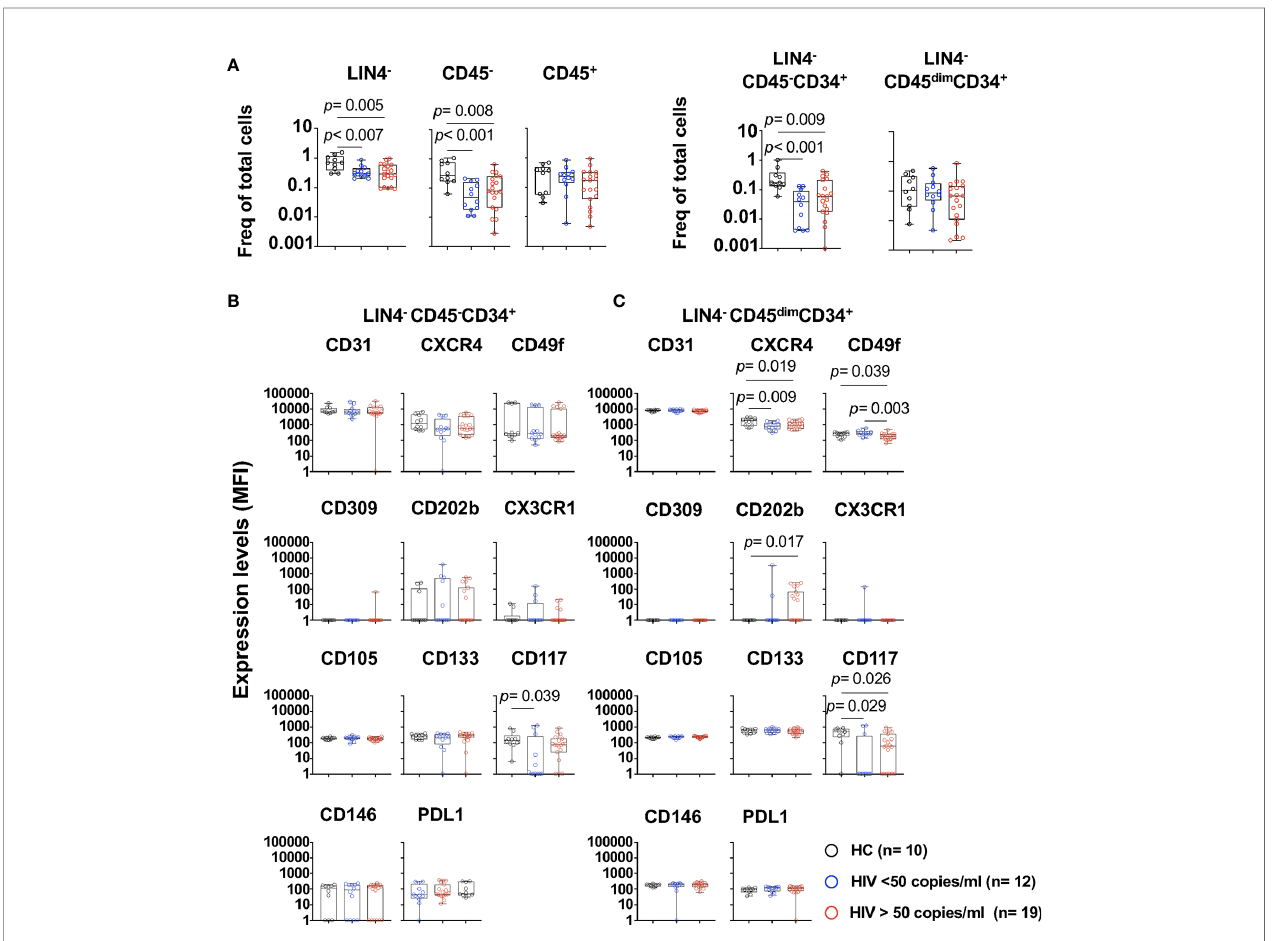
FIGURE 2 | Phenotype of circulating cell progenitors LIN4 - CD45 - CD34 + and LIN4 - CD45 dim CD34 + in PWH. PBMCs from healthy control (HC, n=10), PWH with viral loads < 50 copies/ml (n= 12), and > 50 copies/ml (n= 19) were thawed and rested overnight. PBMCs were stained with LIVE/DEAD followed by a cocktail of mAbs: LIN4, CD45, CD34, CD31, CXCR4, CD105, CD49f, CD133, CD146, PDL-1, CD309, CD117 and CD202b ( Supplementary Table S2 ). (A) Percentage of LIN4 - , LIN4 - CD45 - and LIN4 - CD45 + (Left panel), and percentage of LIN4 - CD45 - CD34 + and LIN4 - CD45 dim CD34 + (Right panel). Percentages are represented as frequency of total live cells. Expression of the markers in: (B) LIN4 - CD45 - CD34 + , and (C) LIN4 - CD45 dim CD34 + cells. Expression of the markers as shown as median fl uorescence intensity (MFI). Whiskers represent median and IQR. Comparison between groups was performed using non-parametric Mann-Whitney test. P value < 0.05 was considered signi fi